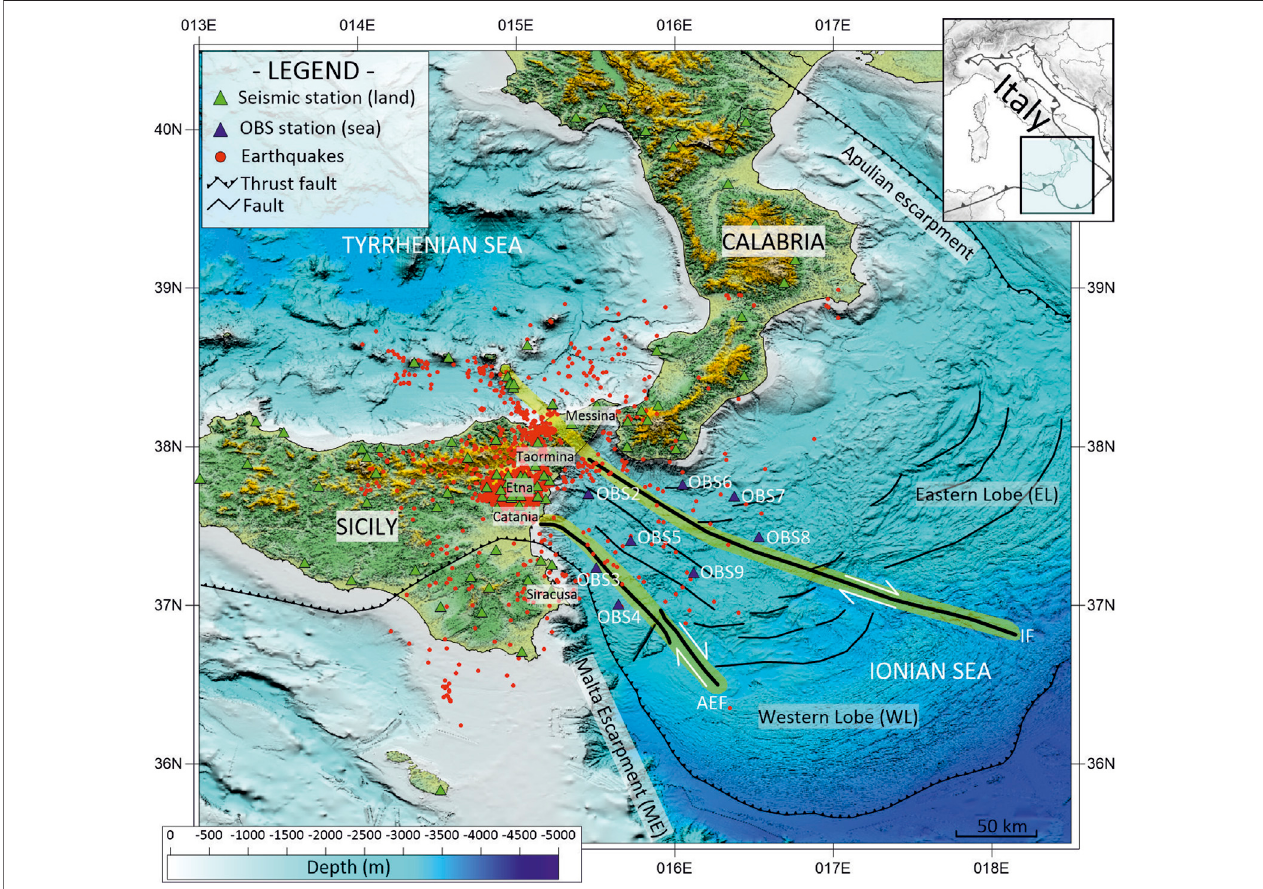
FIGURE 1 | Morphological map of the Western Ionian Sea and surroundings, indicating: main geological features, including Alfeo-Etna Fault (AEF) and Ionian Fault (IF) systems(Polonia et al.,2016),and Maltaescarpment (ME);seismic stations used inthiswork( fi lledgreentrianglesare landstations; fi lledbluetrianglesrepresentthe OBSs); red dots indicate the locations of earthquakes from the land seismic bulletin of INGV and occurring during the SEISMOFAULTS experiment. About 2,400 events were located by INGV seismological network. Bathymetric data were obtained from high resolution multibeam soundings during the SEISMOFAULTS fi rst cruise (Cuffaro et al., 2019; Billi et al., 2020) and merged with DEMs from https://portal.emodnet-bathymetry.eu/.